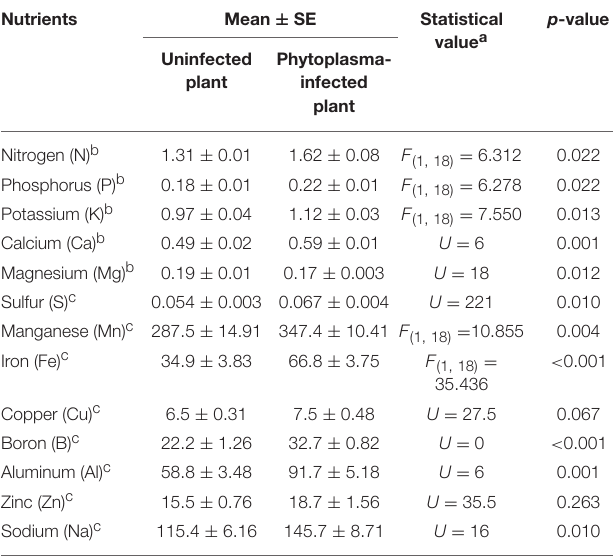
TABLE 1 | Effects of phytoplasma infection on the amounts of nutrients in cranberry leaves.